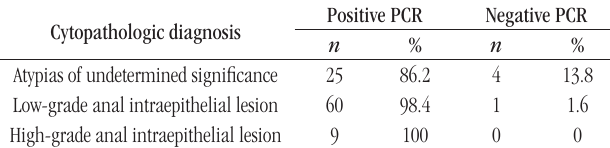
taBLE 5 – Result of the cytopathological diagnosis and PCR for anal HPV DNA in women with cervical neoplasia Cytopathologic diagnosis